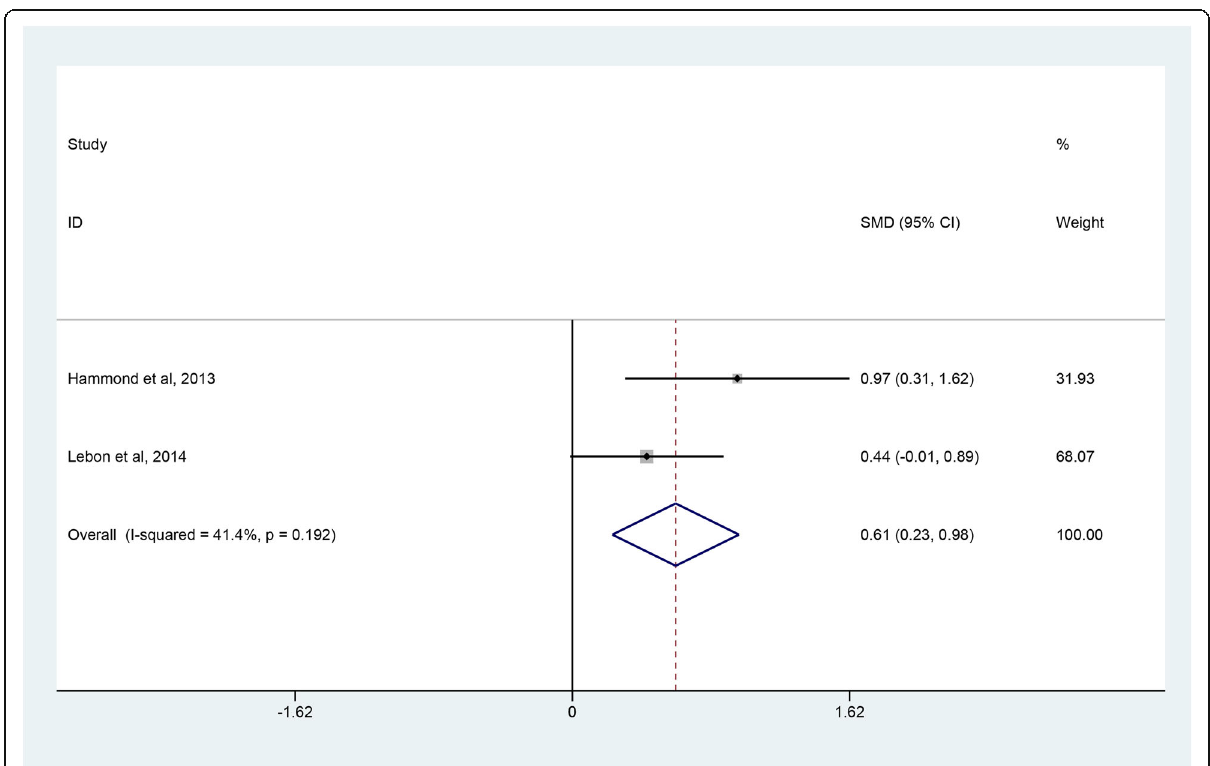
Fig. 9 Forest plot comparing VAS scores after resurfacing hemiarthroplasty (RHA) versus stemmed hemiarthroplasty